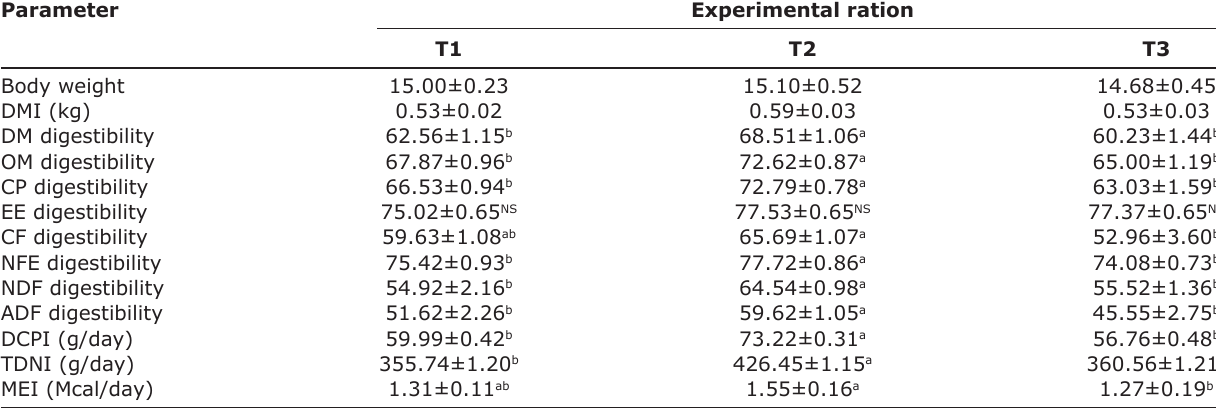
Table-4: Effect of feeding different levels of guar meal on dry matter intake, nutrient digestibility and plane of nutrition in kids.